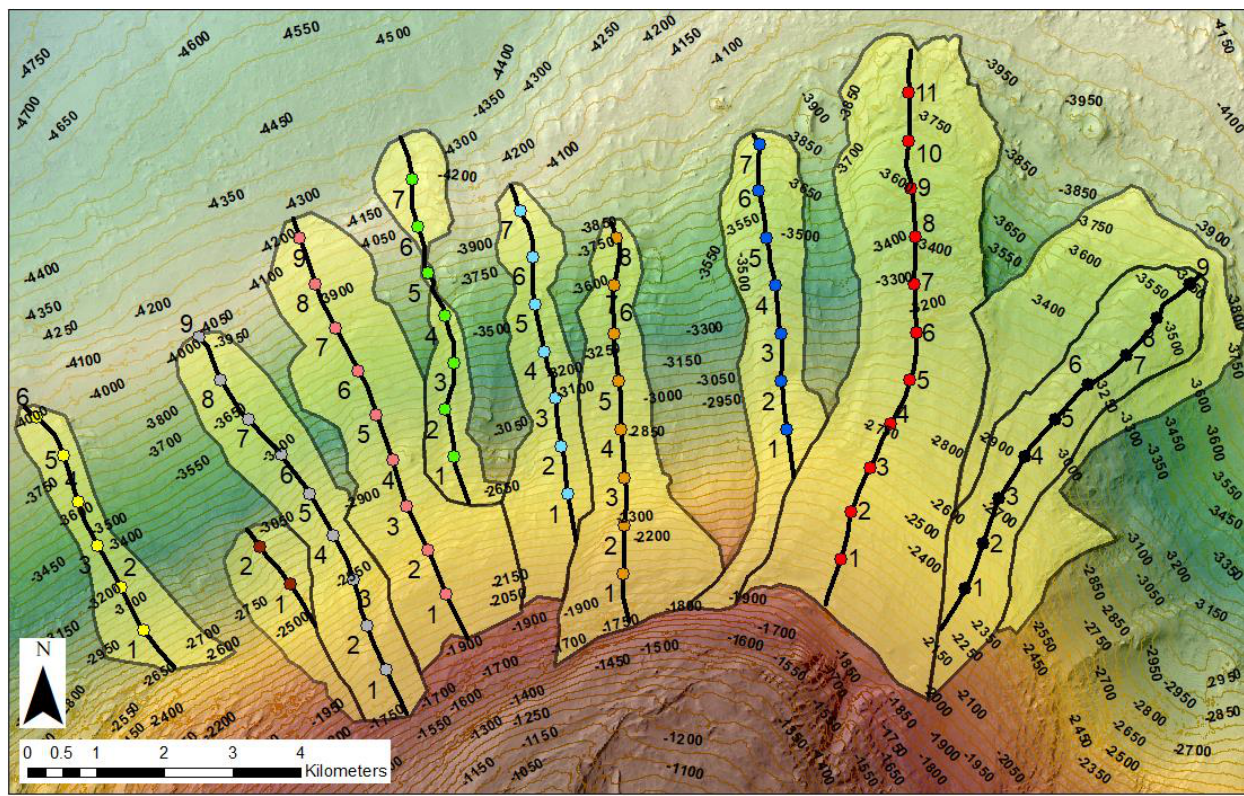
Figure 6. Lobate features on the north face of Mount Sharp. Eleven lobes mapped (0–10) and ten analyzed (1–10). Lobe (0) is overlapped and partially obscured by lobe (2), therefore, was not included in this study. Lobe-center transect lines with corresponding equidistant points. Point colors indicate lobe color designation used in text. CTX base image: B16_016085_1750_XN_05S222W and